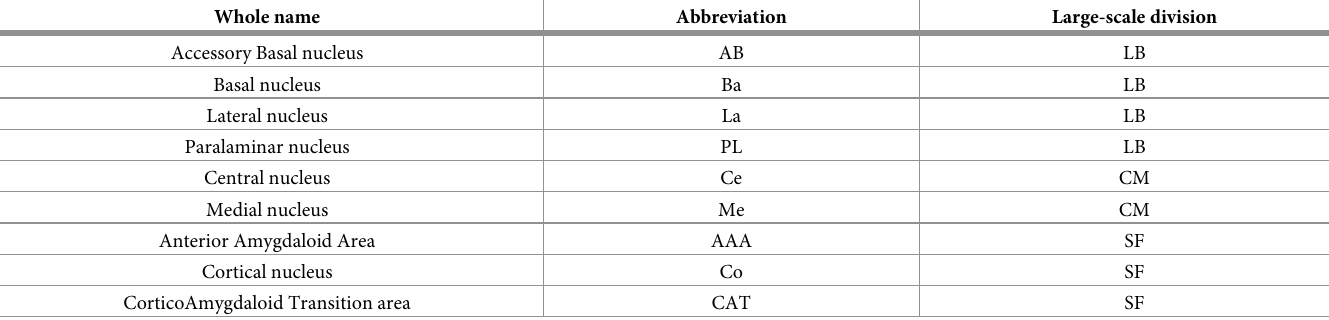
Table 1. Amygdala subnulcei and their